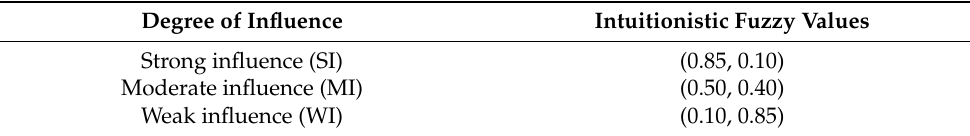
Table 5. Degree of internal influence and the corresponding fuzzy